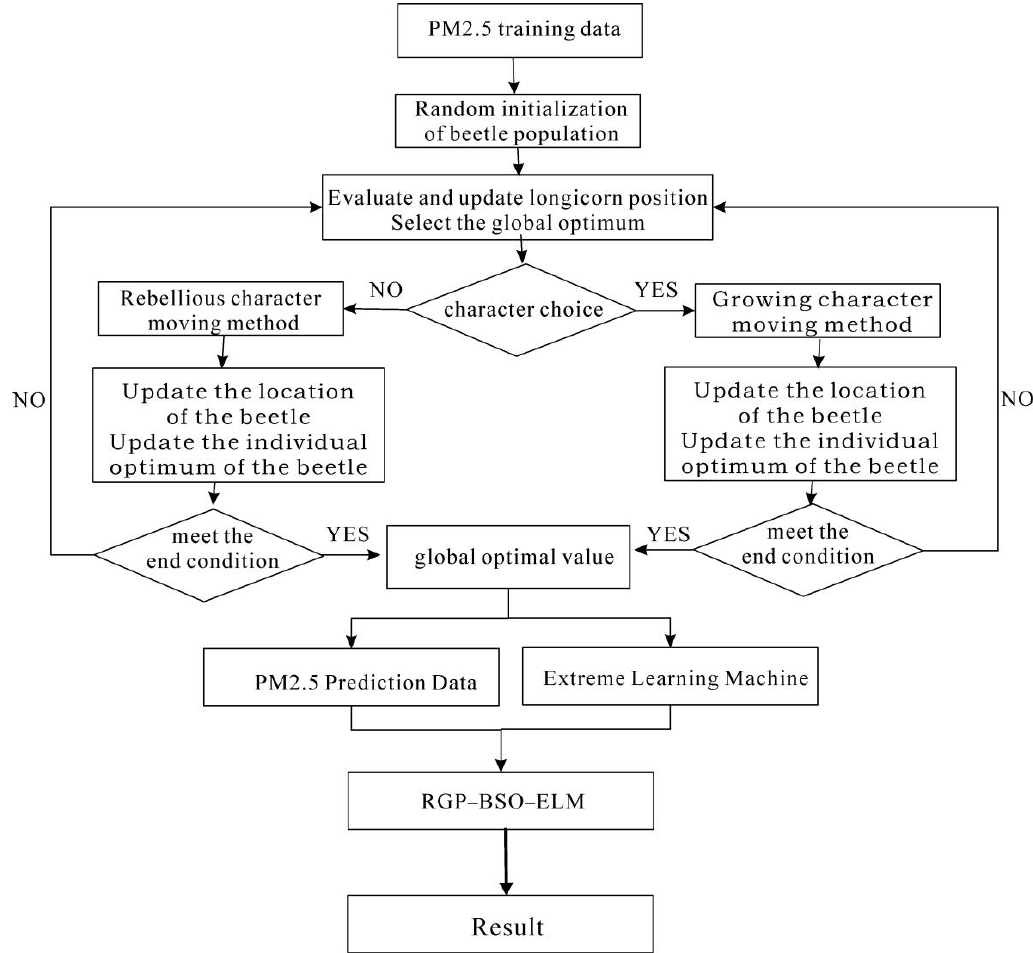
Figure 4. RGP–BSO–ELM Framework Diagram.